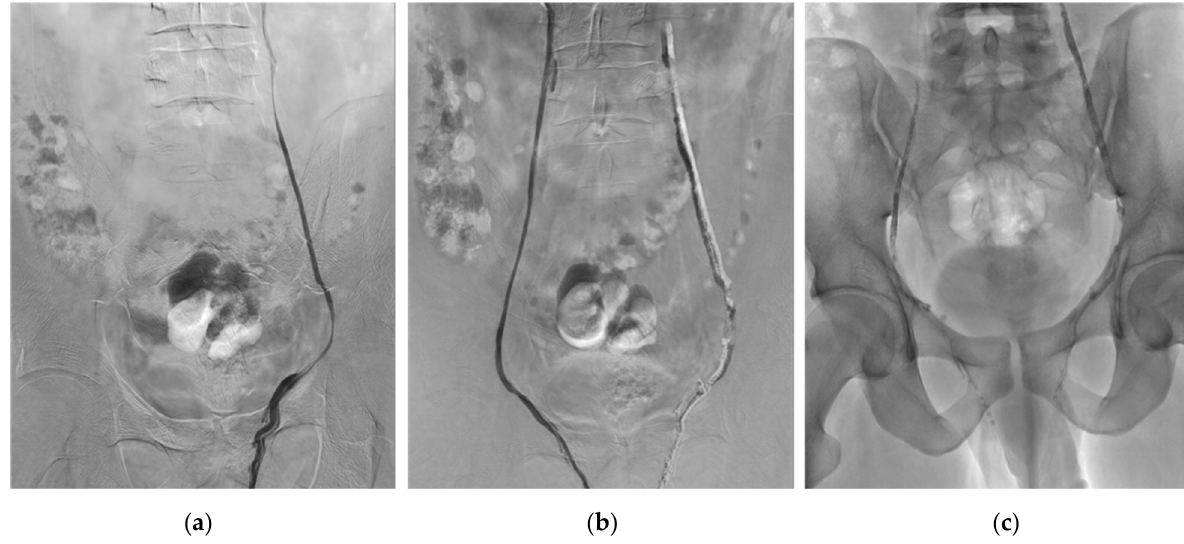
Figure 1. Example of typical bilateral varicocele embolization (VE) procedure using NBCA-MS Glubran ® 2. ( a ) Left gonadal vein venography through a 5-French Cobra catheter by transvenous femoral approach. ( b ) Right gonadal vein venography after VE of the left gonadal vein using Glubran ® 2-Lipiodol ® mixture at a 1:1 ratio. ( c ) Plain X-ray image after bilateral VE using Glubran ® 2-Lipiodol ® mixture at a 1:1 ratio. In more detail, a microcatheter is placed below the iliopectinal line and the dead space is filled with 5% dextrose solution to avoid intracatheter glue polymerization. The embolization procedure is then performed using glue mixed with Lipiodol at a ratio of 1:1. Glue–Lipiodol mixture is then injected under strict fluoroscopic guidance, with continuous injection performed manually and a display of real-time distribution. The glue injection begins in the distal intrapelvic segment of the gonadal vein, and the catheter is withdrawn slowly while injecting NBCA-MS under fluoroscopy. Injection is then stopped before the pampiniform plexus is reached. The microcatheter is then removed when the glue fills the venous space selected beforehand. Here we can see the cast of glue along the left and right gonadal veins after